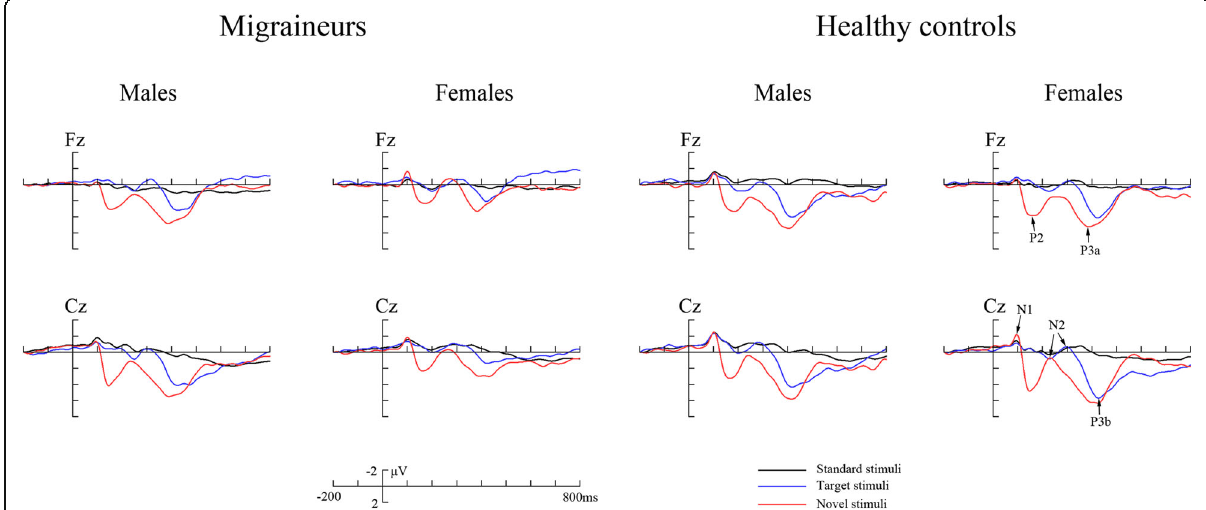
Fig. 1 The grand averaged ERP waveforms in migraineurs and healthy controls at Fz and Cz, respectively. Original waveforms are elicited by standard (black), target (blue) and novel stimuli (red